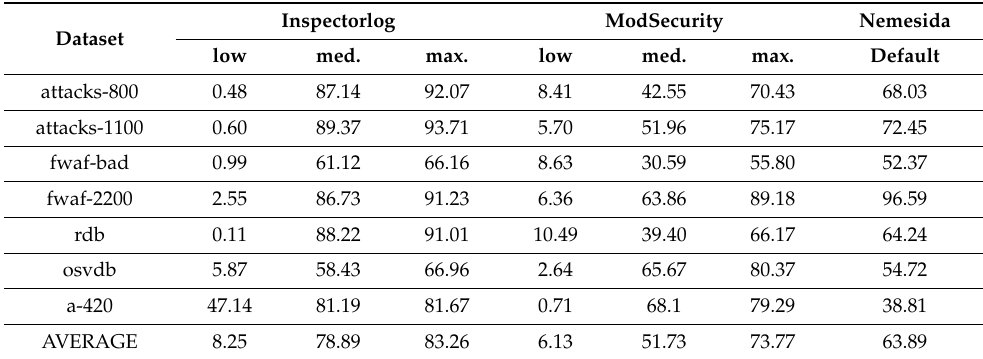
Table 3. Detection rate or recall (percentage of attacks